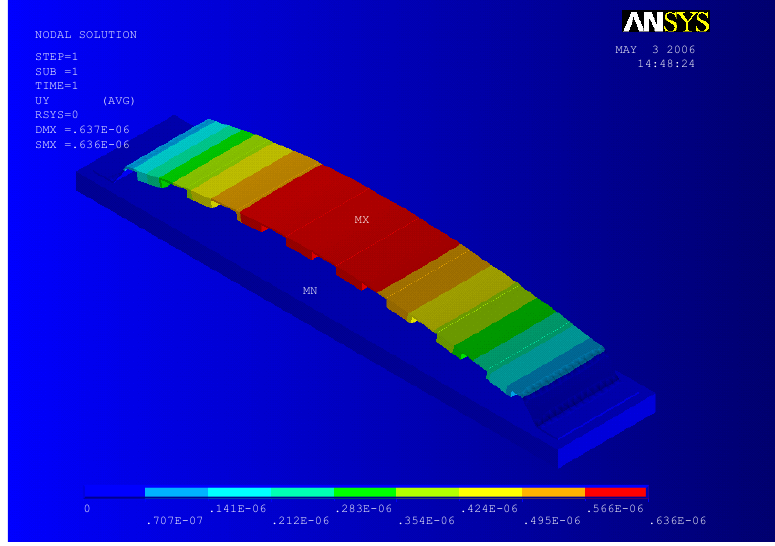
= 91 µm , W = 20 µm , t = 0.4 µm m m m